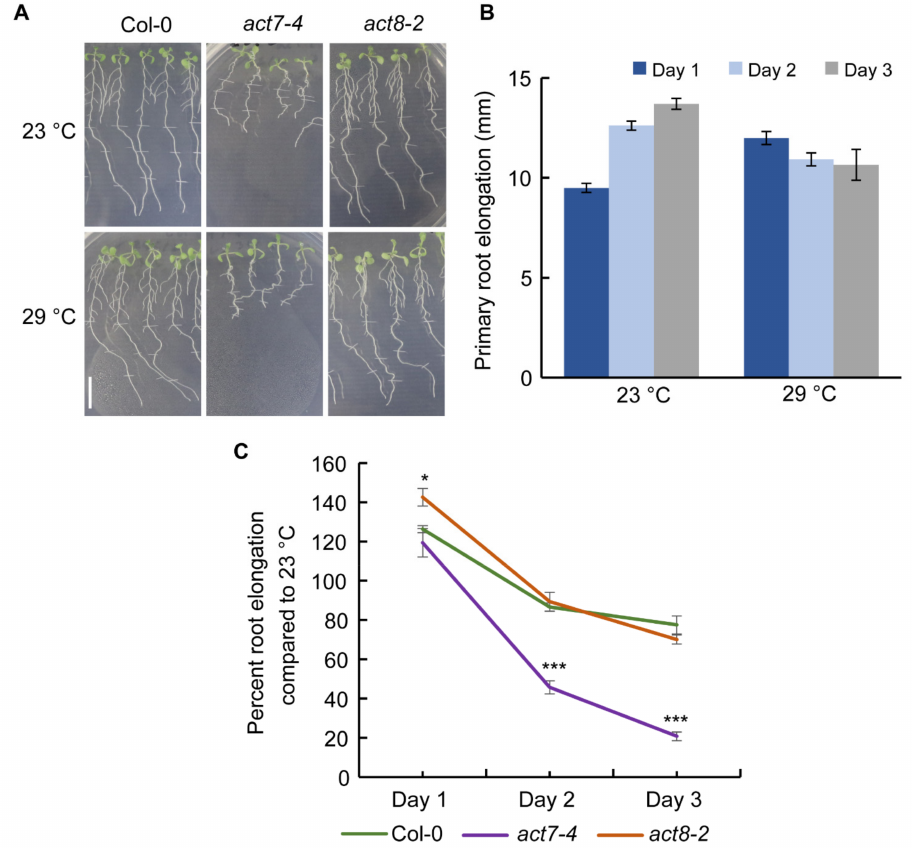
Figure 1. Effect of prolonged moderate-high temperature on root elongation of Col-0, act7-4 , and act8-2 mutants. ( A ) Phenotype of primary root elongation of Col-0, act7-4 , and act8-2 for 3 consecutive days at 23 ◦ C and 29 ◦ C. Root elongation was marked after every 24 h (Scale bar = 10 mm). ( B ) Primary